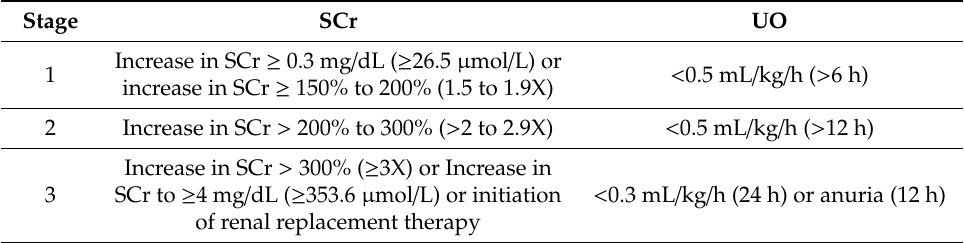
Table 1. Kidney Disease Improving Global Outcomes (KDIGO)